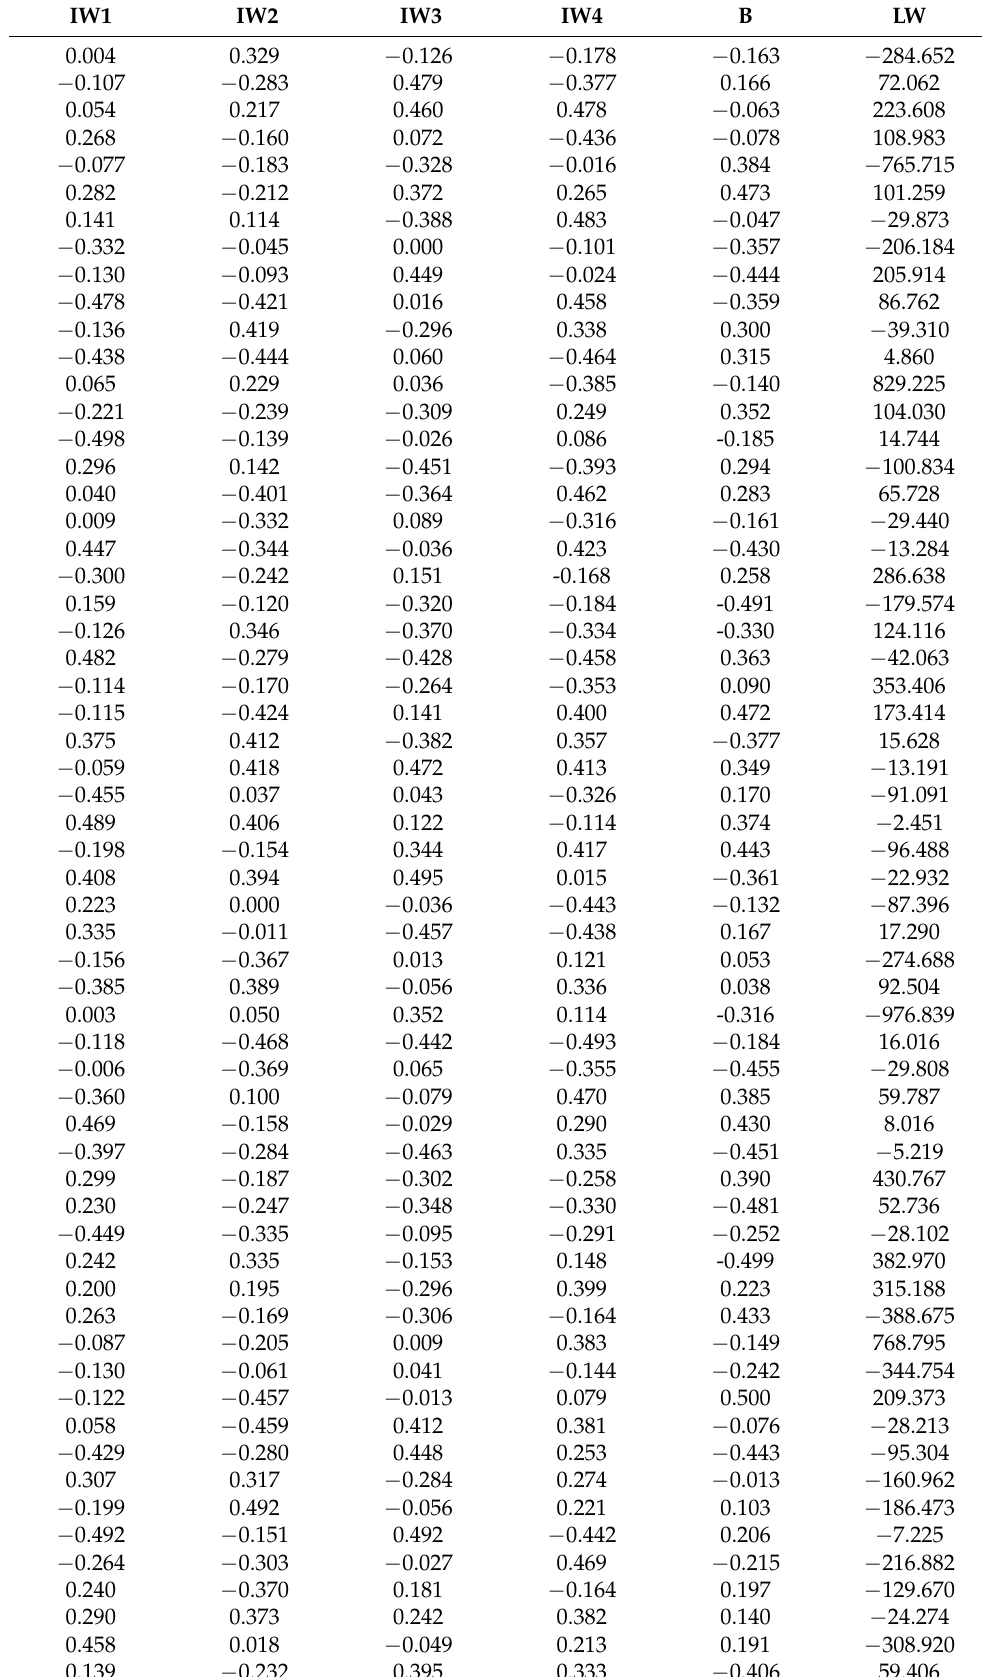
Table A3. The connection weights and thresholds of